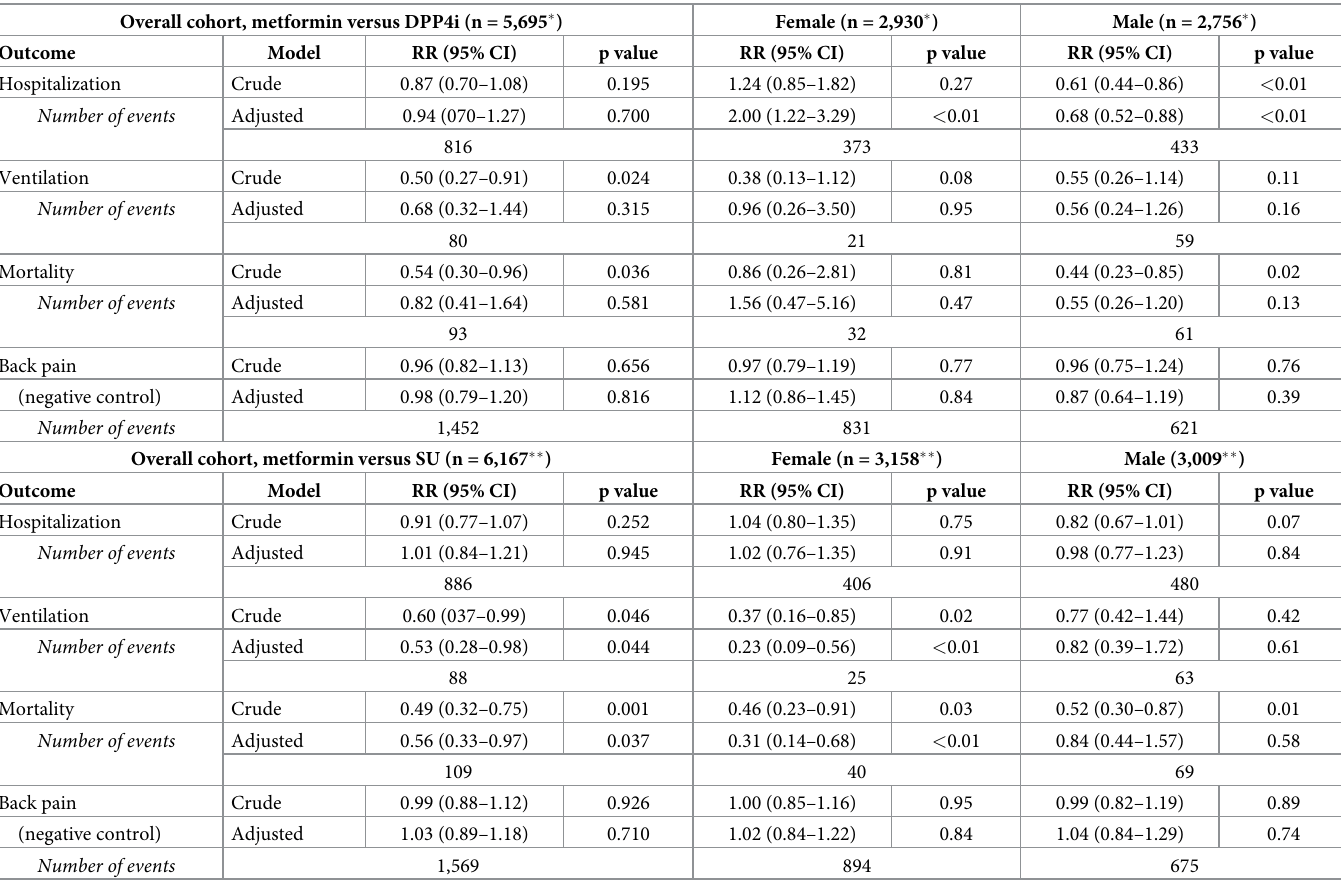
Table 2. Risk ratios for severe COVID-19 outcomes in the overall cohort as well as subgroups by gender. Overall cohort, metformin versus DPP4i (n = 5,695 �